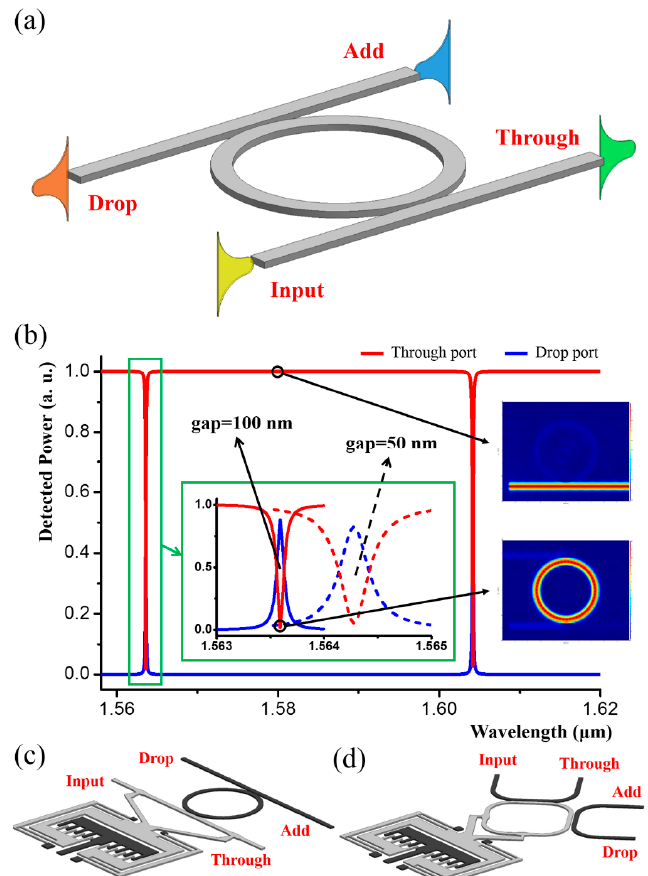
Figure 6. ( a ) Schematic of an add-drop filter based on a ring resonator. ( b ) FDTD simulation results of the filter. The red and blue curves denote the normalized power detected by the monitors at the through and drop ports respectively. Mode profiles of the through and drop state are given as the inserts on the right-hand side. ( c , d ) Schematics of the tuning mechanisms by mechanically moving ( c ) the channel waveguide and ( d ) the ring.